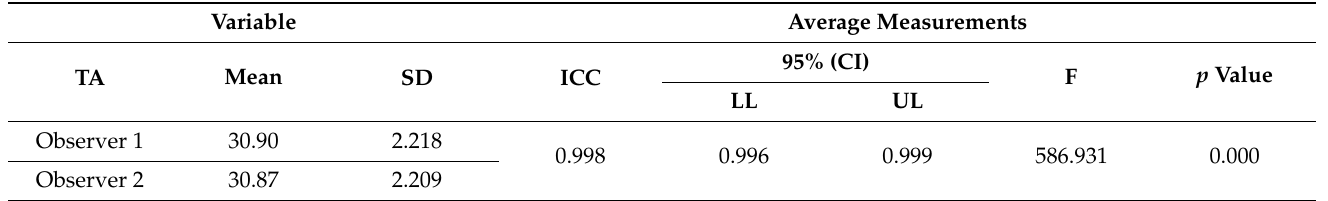
Table 6. Values in the ICC in the interobserver assessment of Type of Action (TA) and average measurement.